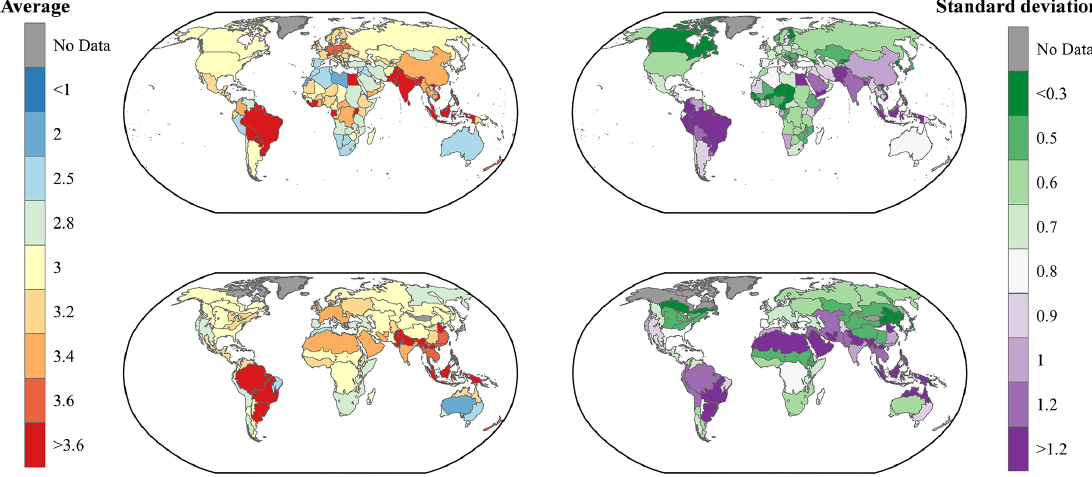
Figure 8. Average and standard deviation (SD) of TNCC during 2016 to 2018 at the national and AEZ